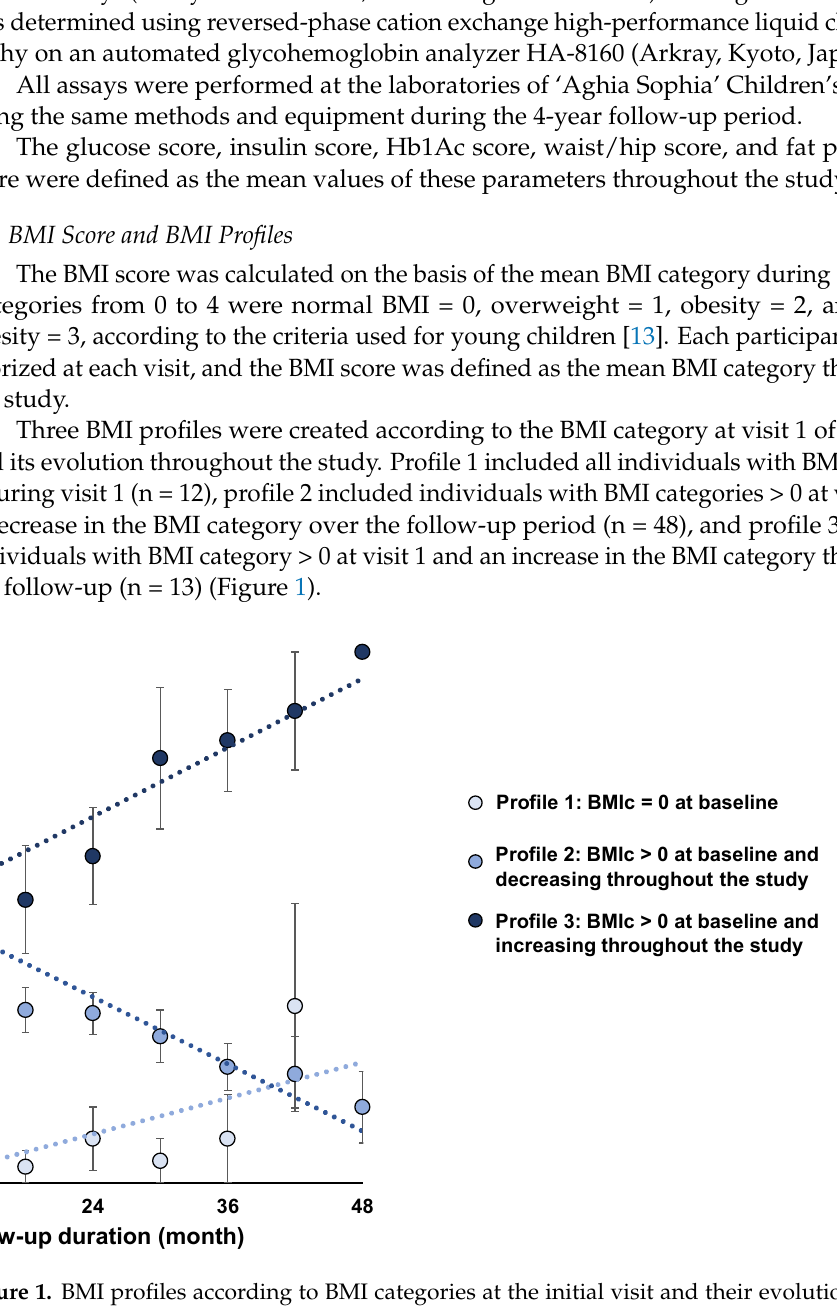
Figure 1. BMI profiles according to BMI categories at the initial visit and their evolution over the follow-up period. Values are expressed as means ± SEM; BMIc = body mass index category.